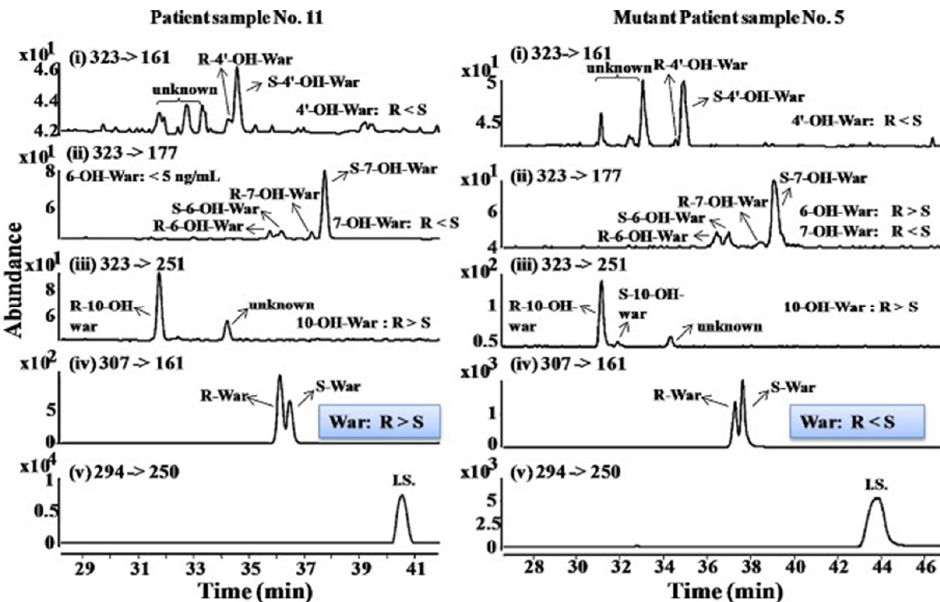
Figure 8. Extracted ion chromatograms of subject 11 and subject 5 (with mutant gene CYP2C9 ′ 2 or ′ 3). The MEKC-MS/MS conditions are the same as in Table 2 (row 2). The figure is adapted from